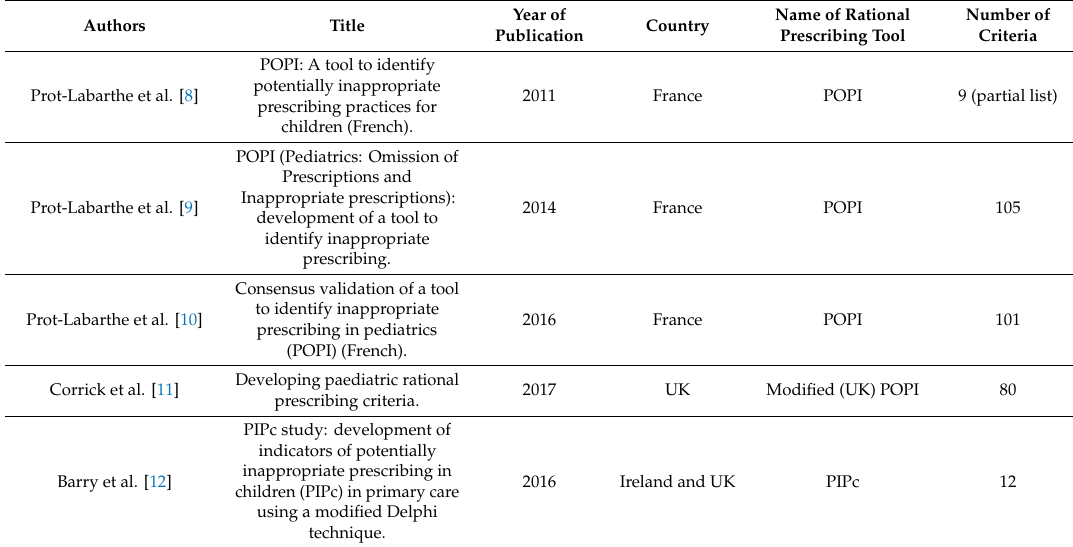
Table 1. Results of systematic literature